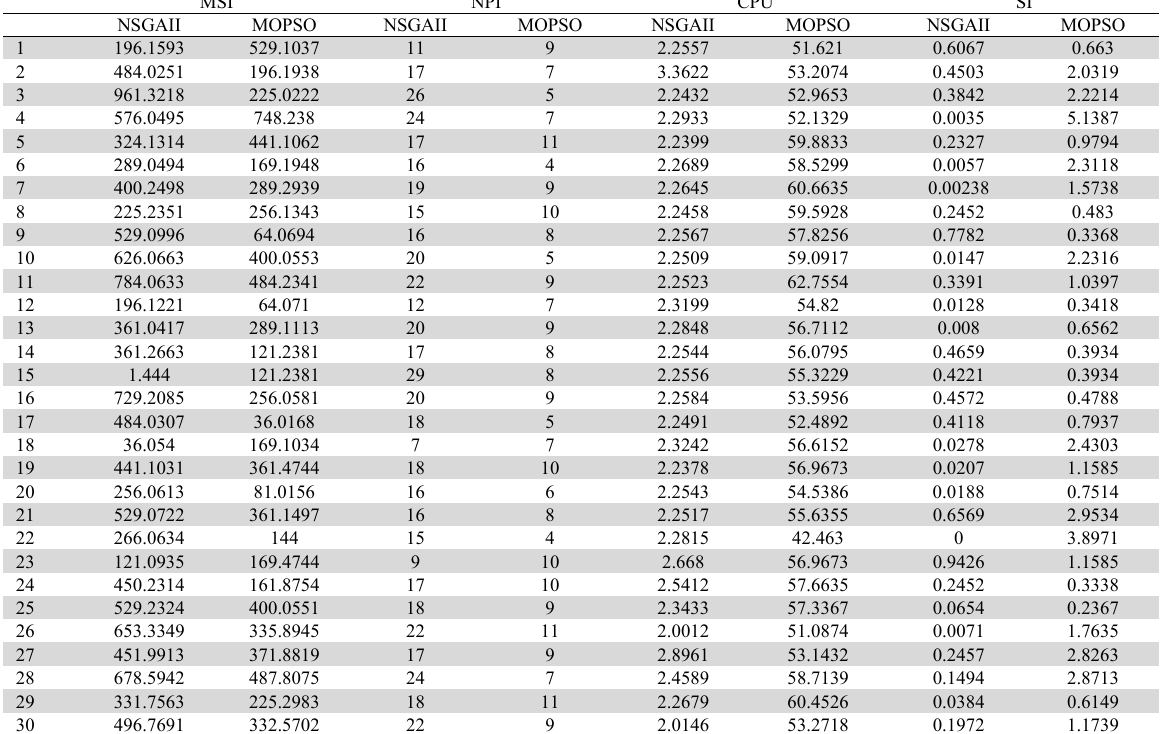
Table A.1 demonstrates the results of the implementation of TOPSIS method. Table A.1 The results of the implementation of TOPSIS method for comparing the performance of NSGA II versus